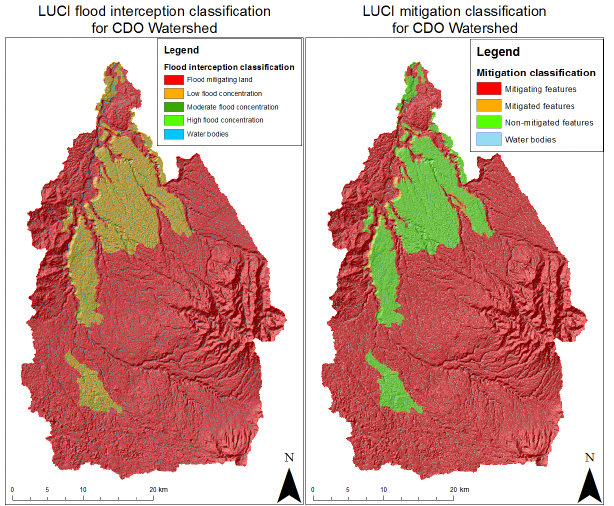
Figure 3. Flood interception and mitigation classification for the CDO watershed.